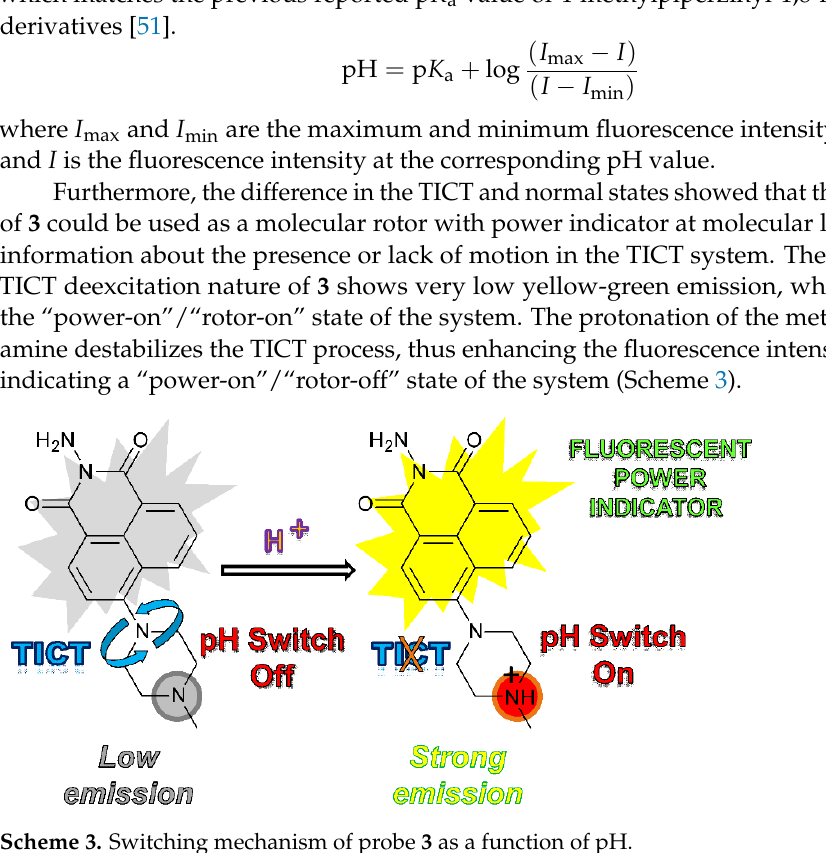
Figure 2. ( A ) Fluorescent spectra of probe 3 in 100% aqueous solution in a pH interval of 4 – 12 ( λ ex = 400 nm) and ( B ) pH titration plot of probe 3 fluorescence intensity at 530